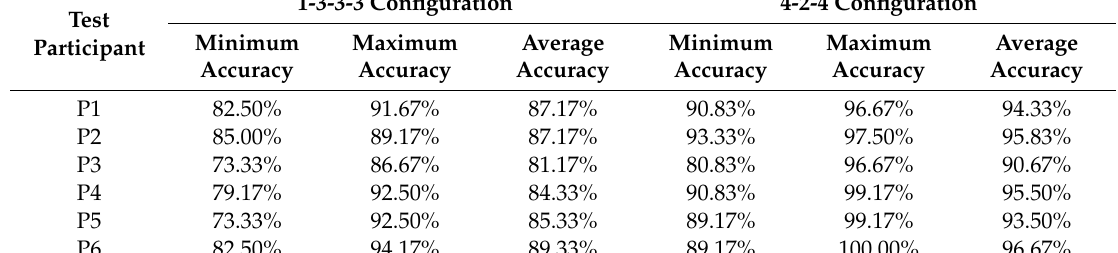
(b) Figure 7. Spacing of vibration motors for preliminary test: ( a ) 1-3-3-3 configuration;